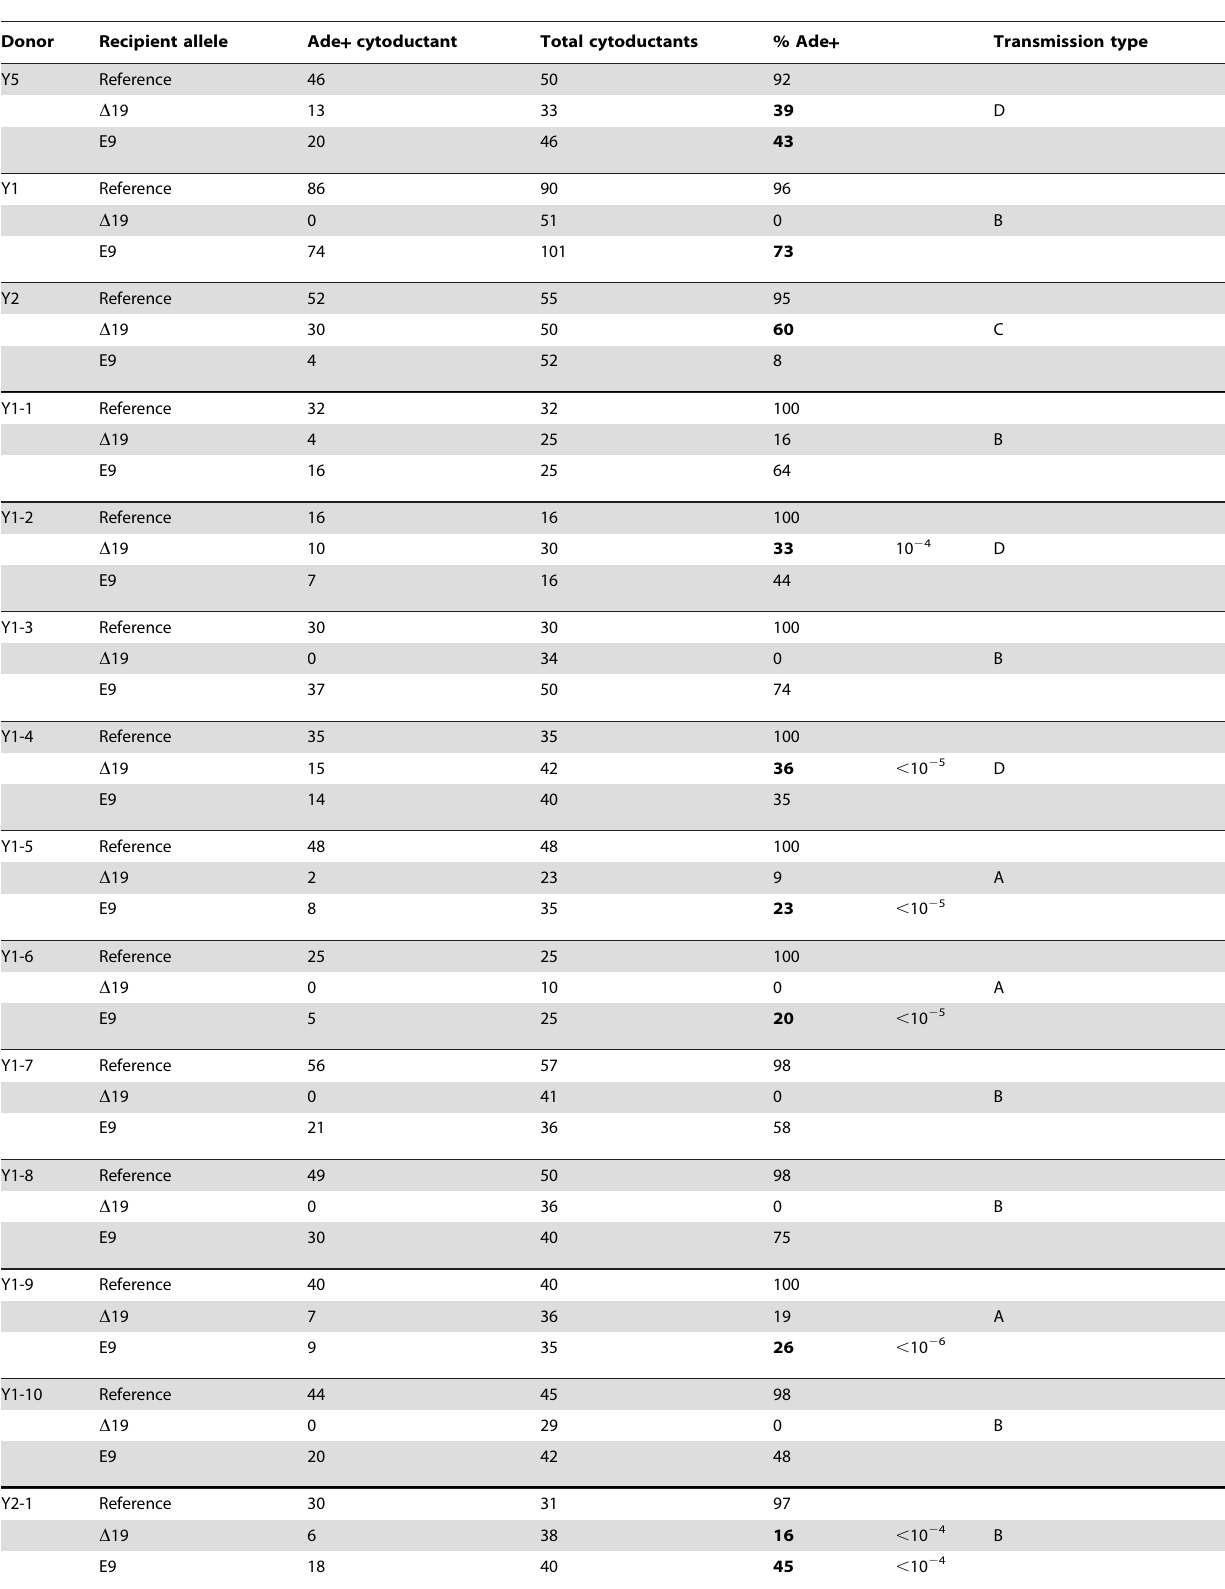
Table 6. Instability of transmission variants on extensive mitotic